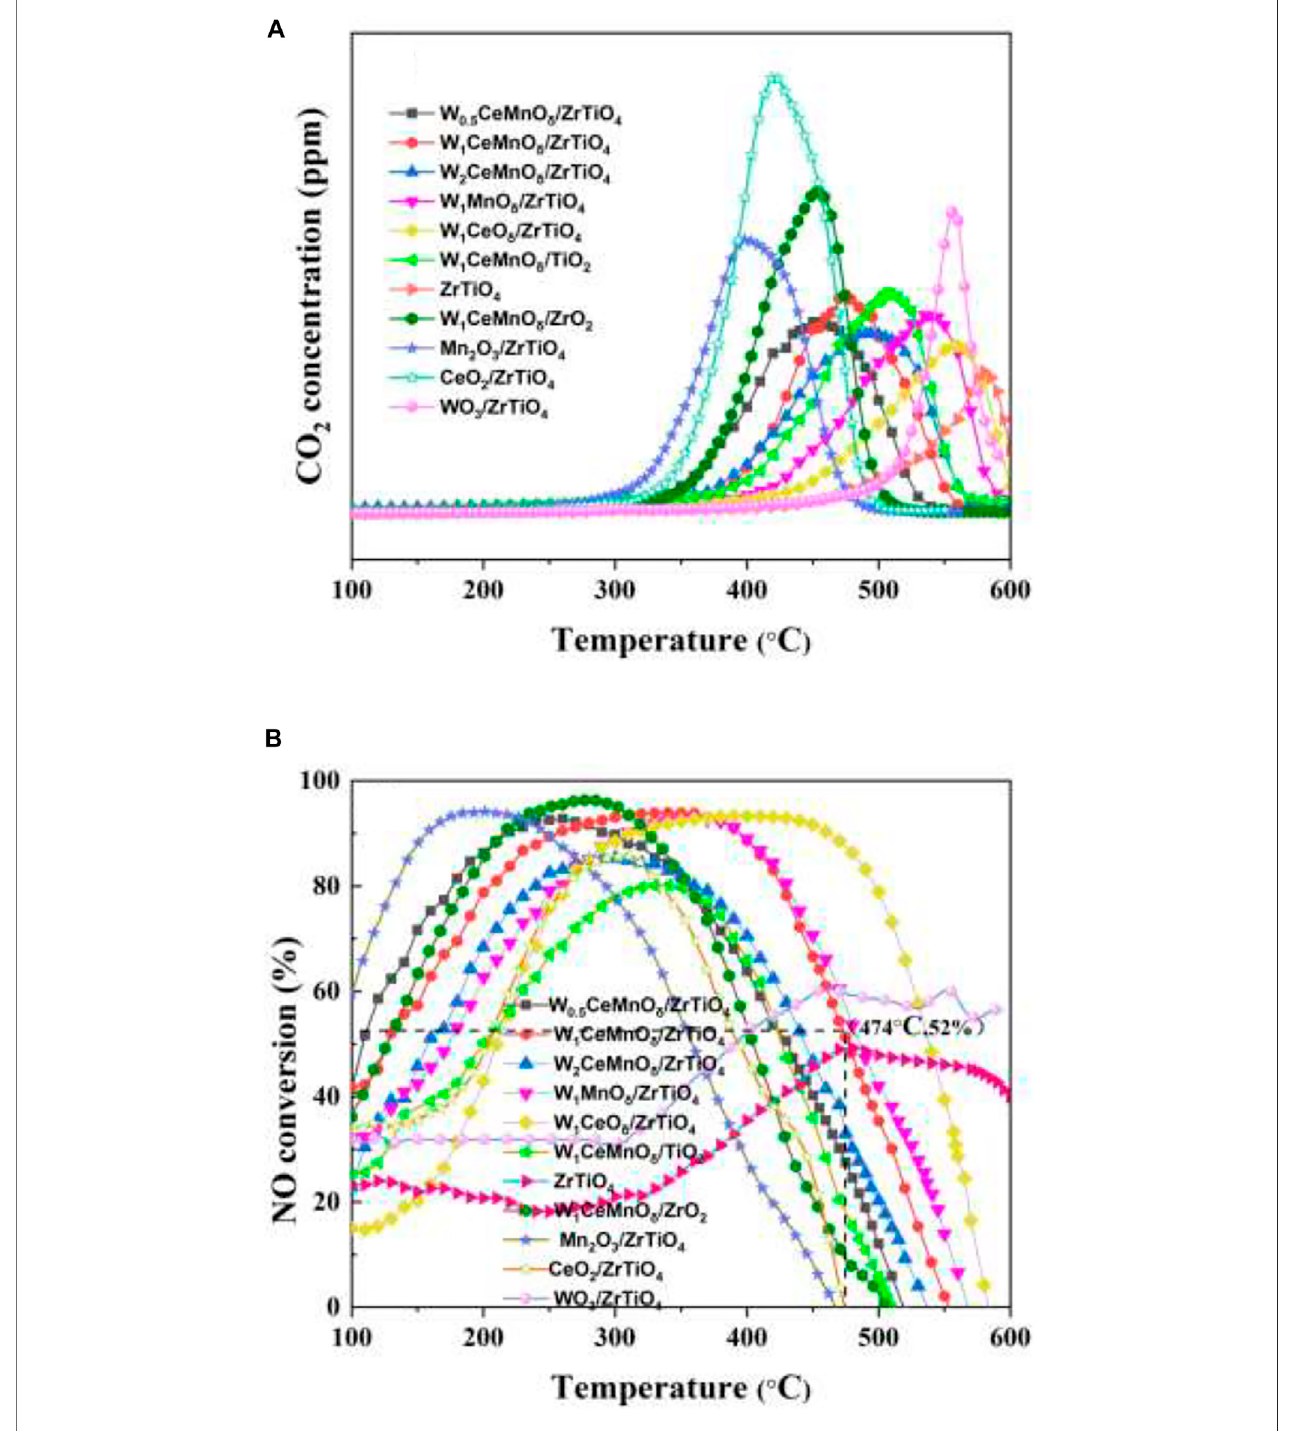
FIGURE 1 | CO 2 concentration cures (A) and NO conversion curves (B) for the simultaneous elimination of PM and NO x over 3DOM catalysts.